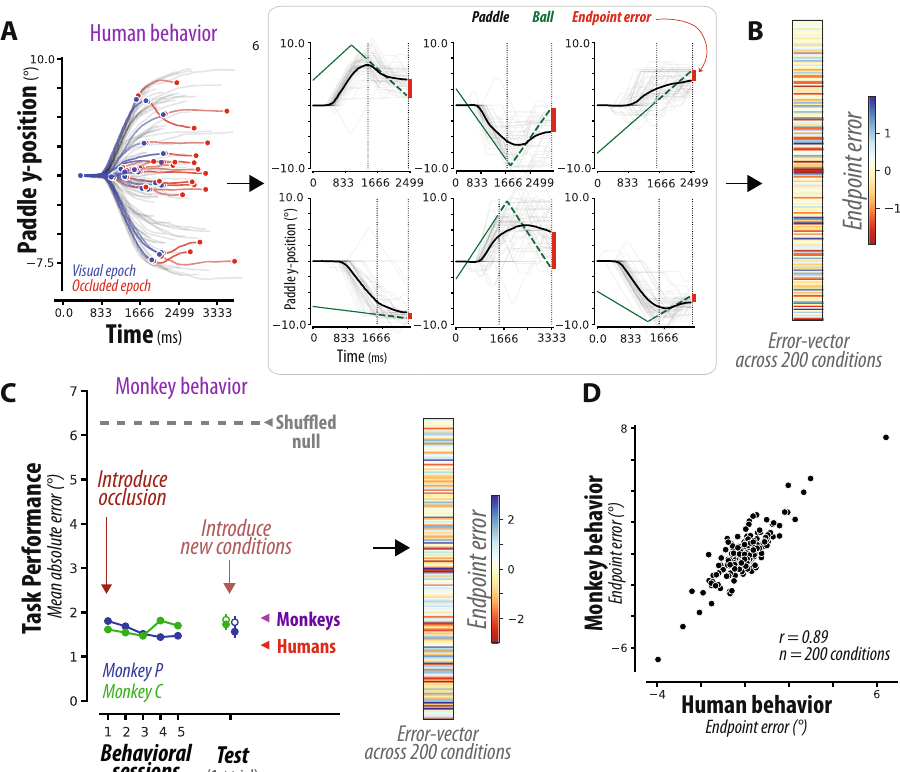
Fig. 2 | Comparing human and monkey behavior. A Human behavior. (left) Each curve corresponds to the paddle position (in units of degrees of visual angle) over time for a single task condition, averaged across dozens of trial repetitions, sepa- ratedintomovementswhiletheballwasvisible(blue)oroccluded(red).(right)For six example task conditions, this average paddle trajectory is overlaid on each individualtrialrepetition(lightgray),aswellasthetrueverticalpositionofthe ball (green), from which the average endpoint error (red) is estimated (see Methods). B Across 200 different task conditions, we measure a pattern of endpoint errors (termed error-vector) to characterize behavior. The error-vector is shown as a colored vector, with colors spanning mean±2SDs of the error range. C Monkey behavior. (left) After training monkeys to manipulate the joystick in order to con- trol a paddle and intercept moving balls, we introduced the occluder, interleaving trials where the ball was completely versus partially occluded. Monkeys reached high performance under occlusion on the very fi rst behavioral session, and main- tained this high performance over subsequent sessions. Furthermore, monkeys